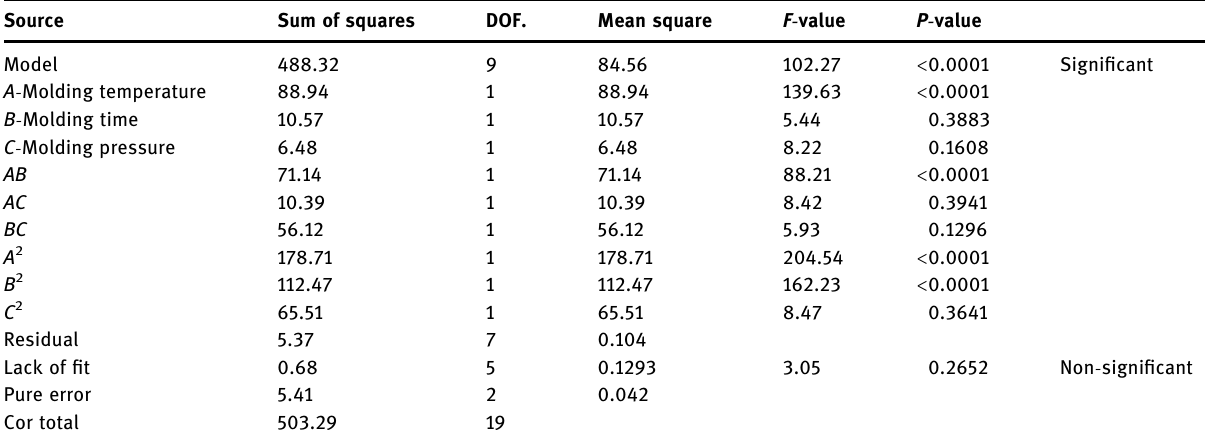
Table 17: ANOVA for adhesion strength Source